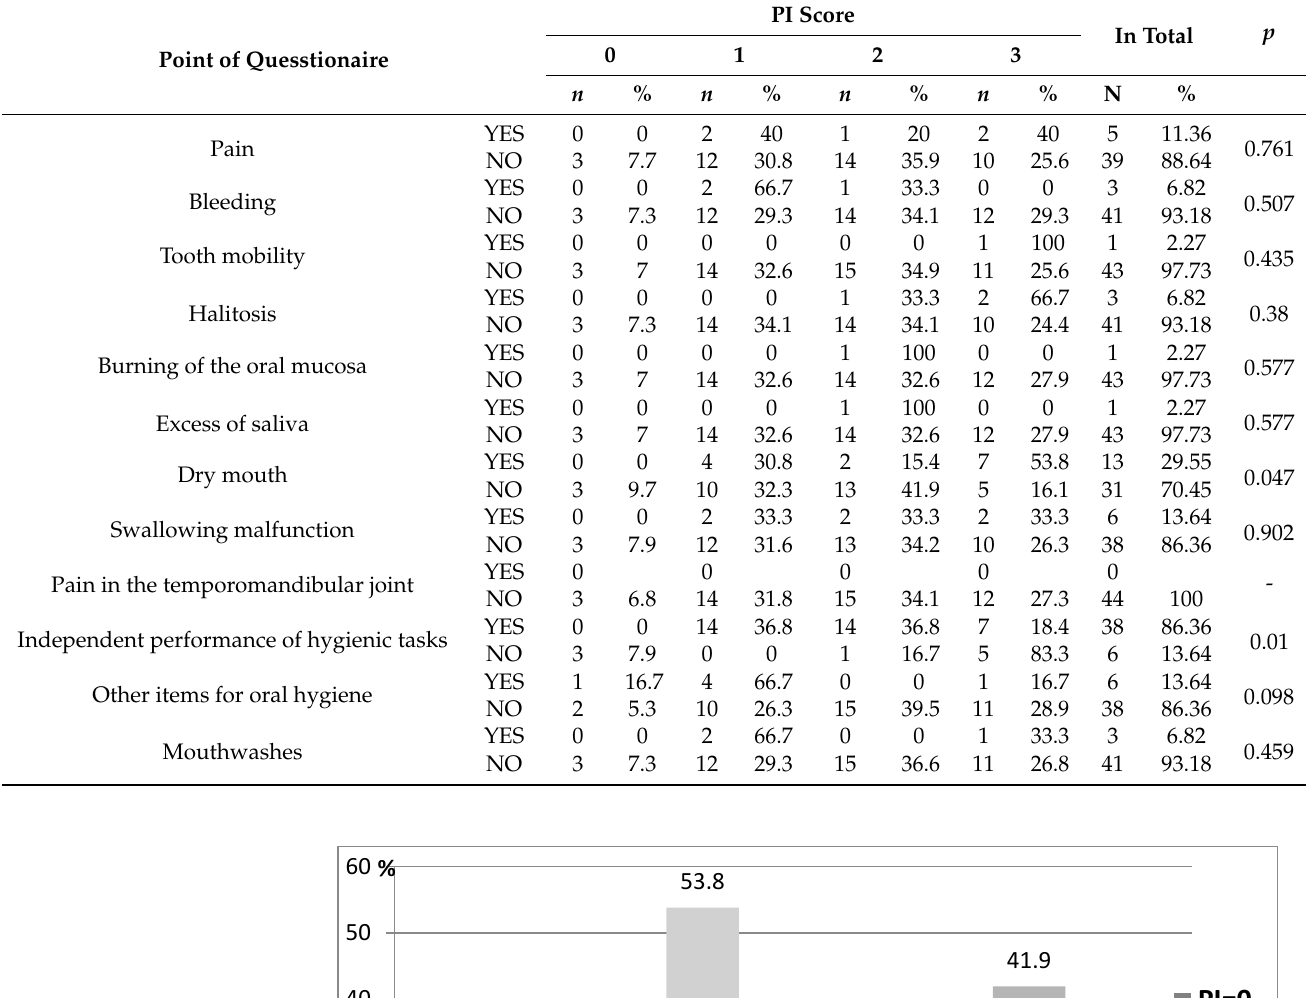
Table 5. Results of the questionnaire in relation to the plaque index.